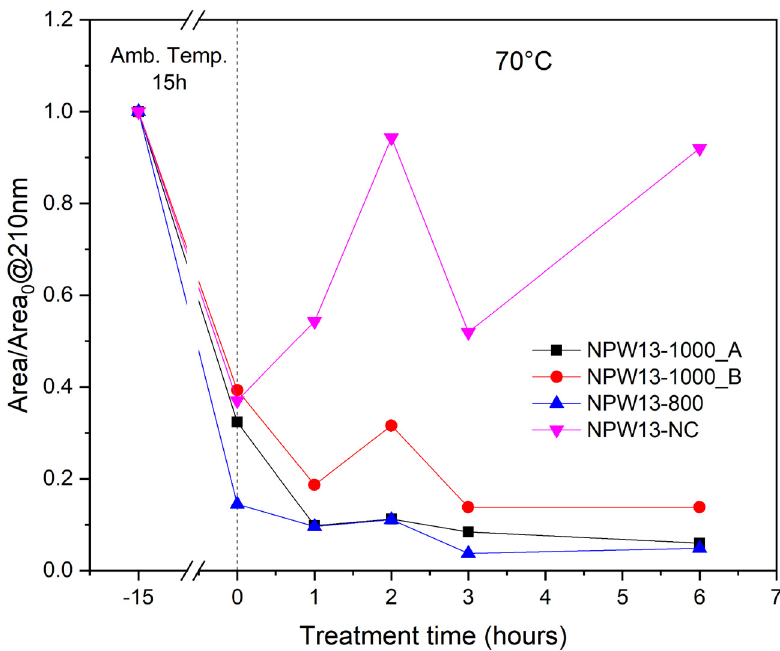
Figure 9. Degradation of BPA 5 mg/L in the presence of NPW13-NC and NPW13 calcined at different temperatures and prepared by Lab B, in comparison with NPW13-1000_A.